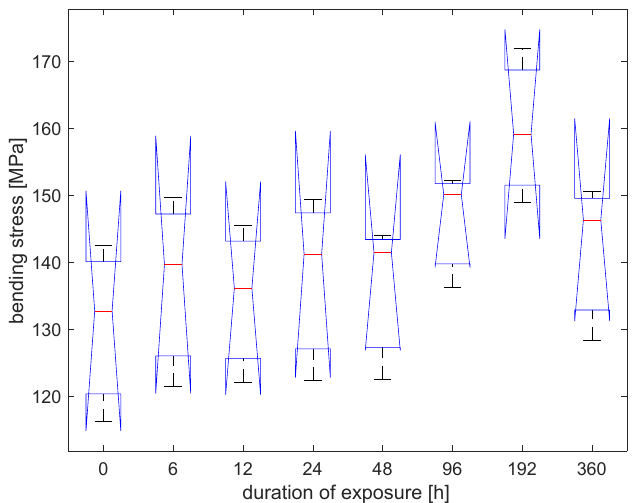
Figure 9. Box plot for the specimens with different durations of the UV irradiation.